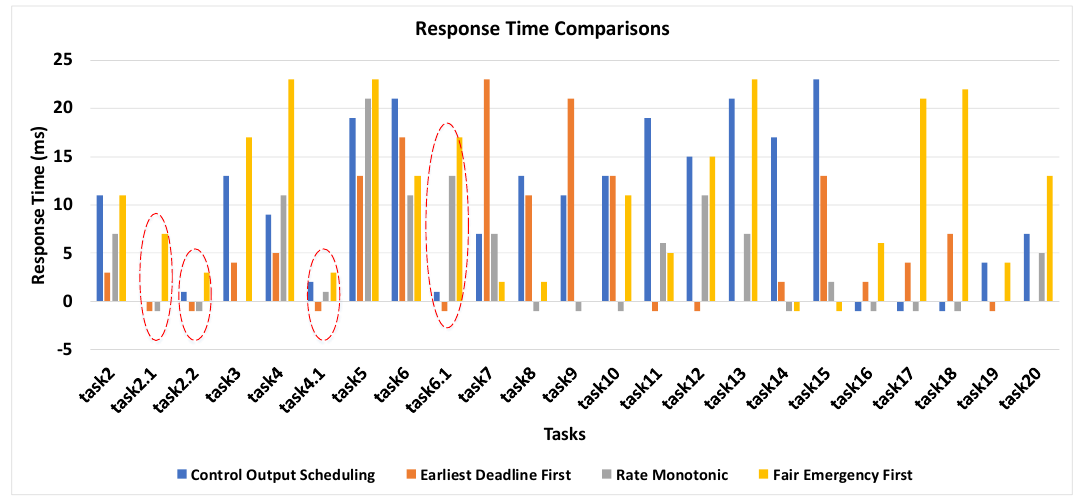
Figure 9. Response time comparison of the rate monotonic, earliest deadline first, fair emergency first, and control output scheduling